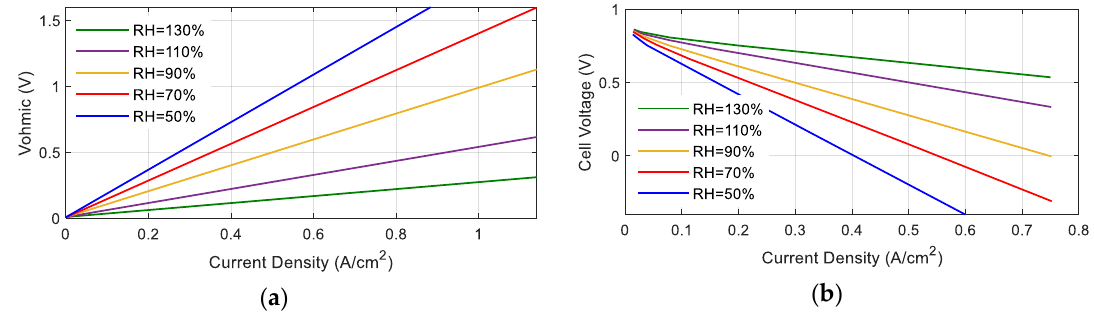
Figure 8. Effect of pressure on ( a ) Activation losses, ( b ) Concentration losses, ( c ) Cell voltage loss.